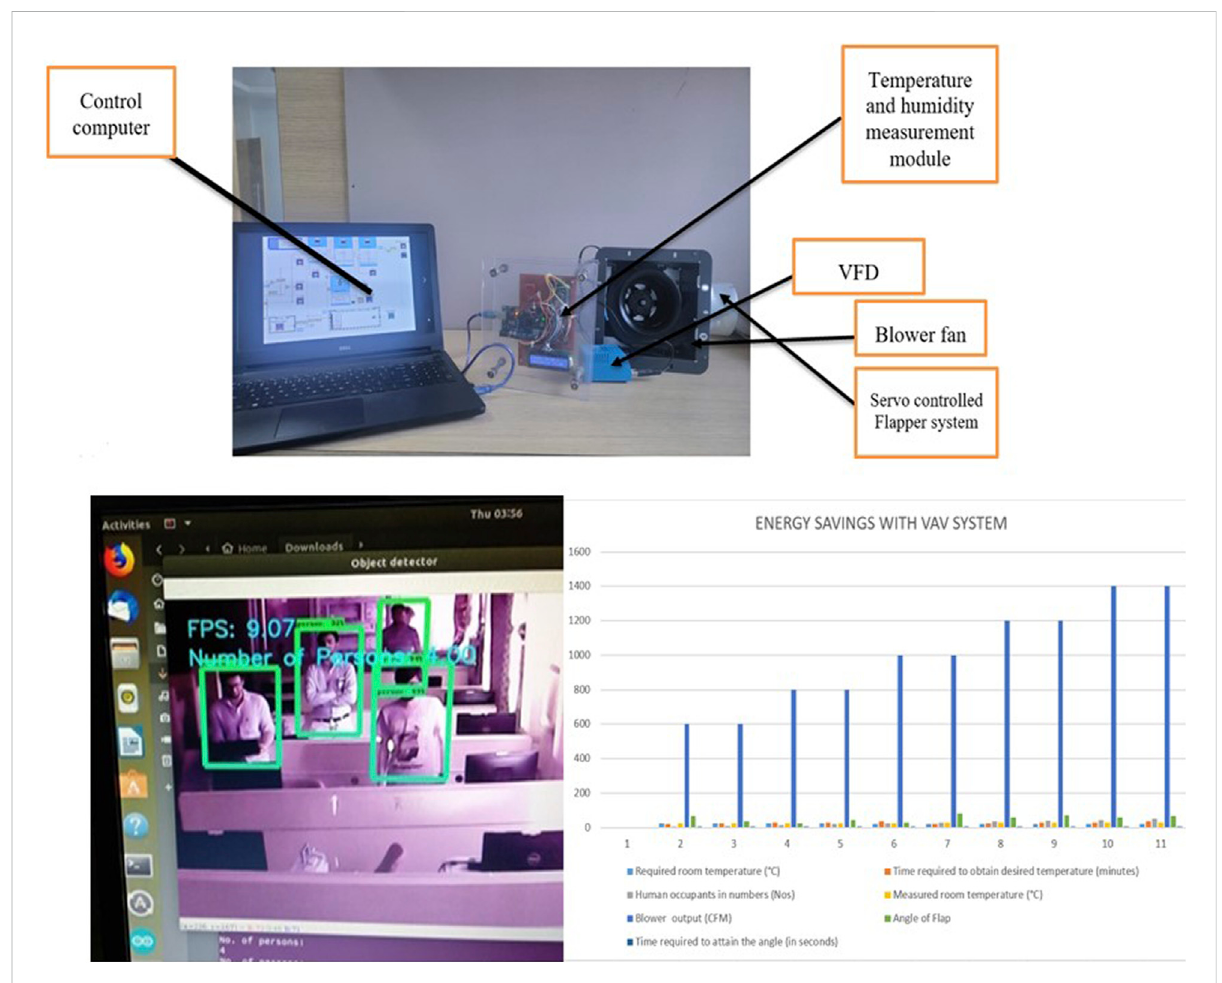
FIGURE 3 Experimental setup, occupancy-detection, and energy savings using the proposed system.